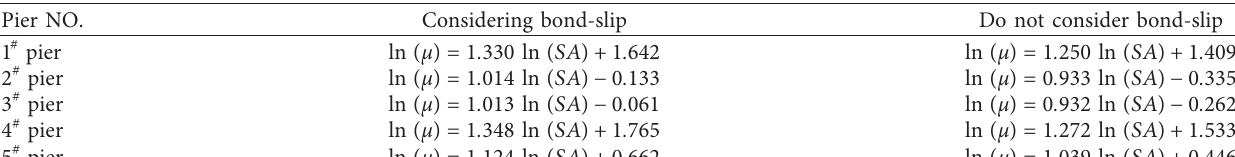
Table 4: Probabilistic demand model of five